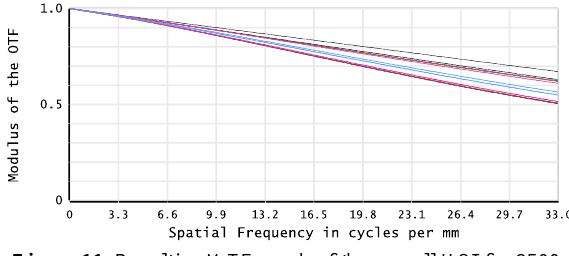
Figure 11. Resulting MTF graph of the overall HSI for 2500 nm Field curvature and distortion values are shown in Figure 12 and Table 10, which meet the project performance goal